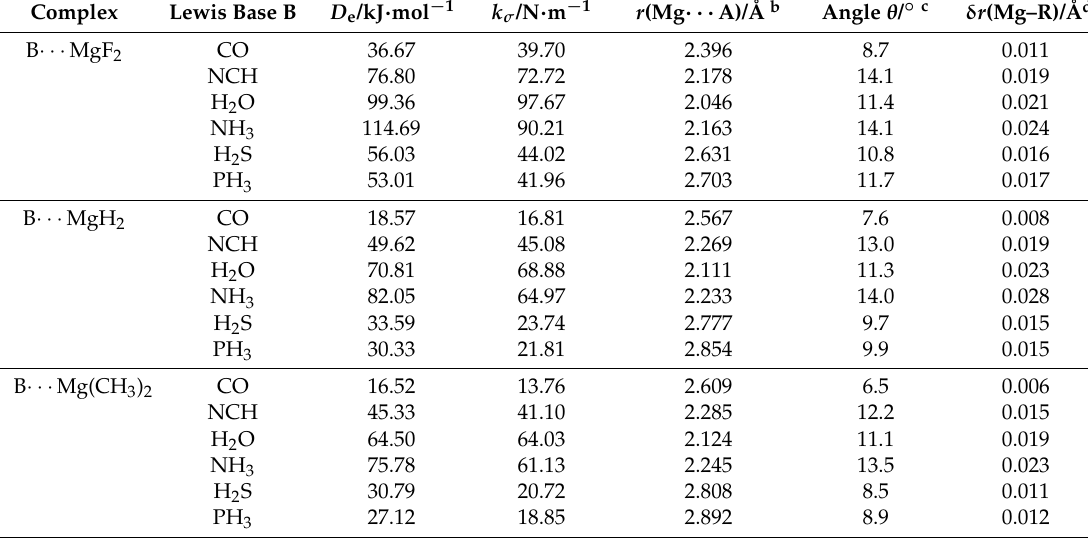
Table 2. Some ab initio calculated properties of the B ··· MgR 2 complexes (R = F, H or CH 3 ) for six different Lewis bases B a